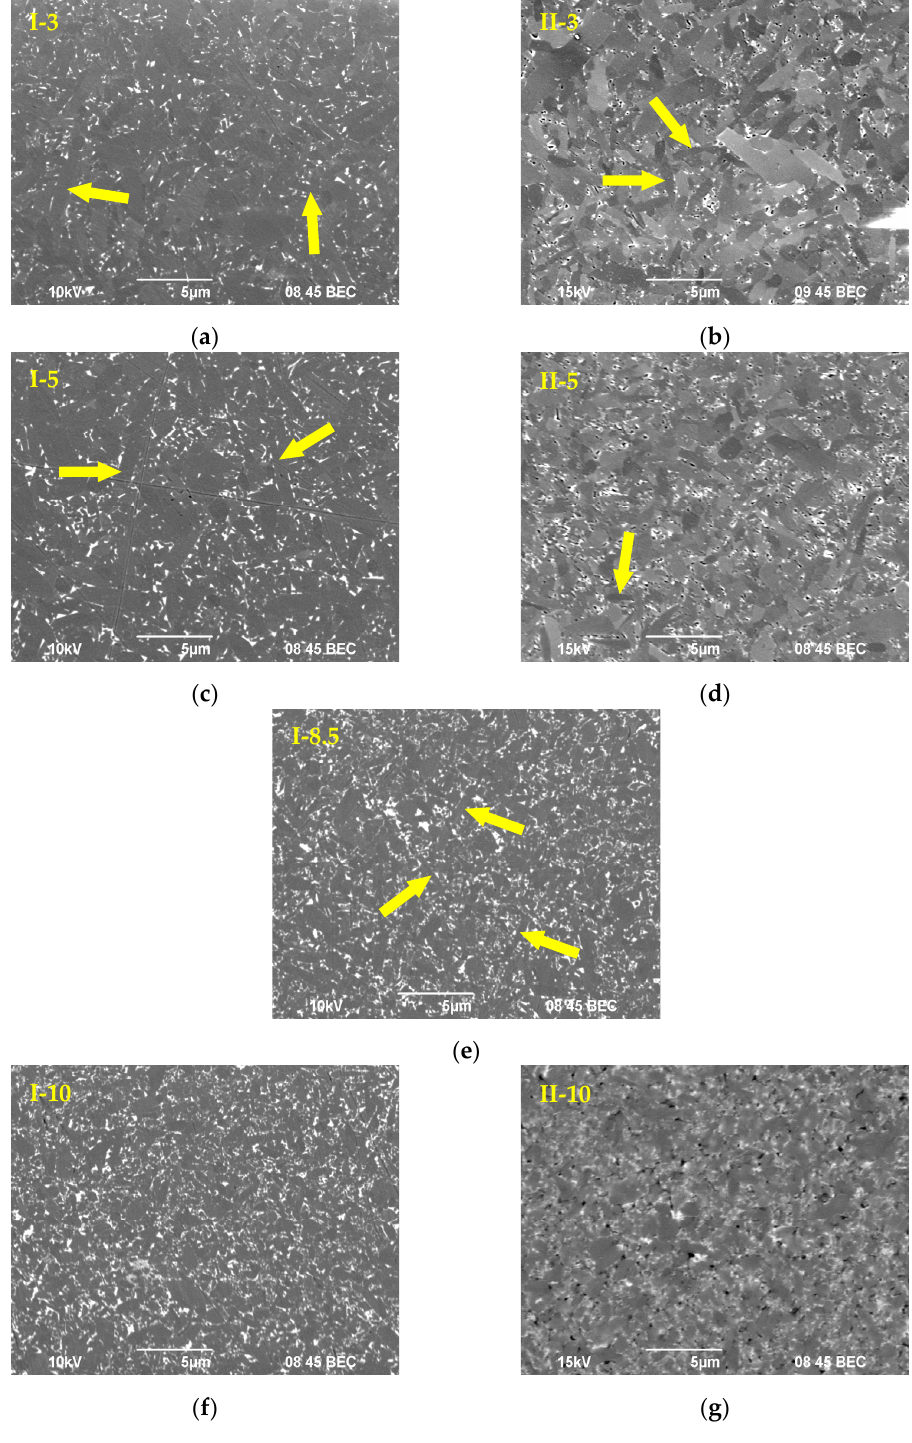
Figure 5. SEM images of the ceramic samples with different amounts of the sintering additive: ( a , b ) 3% wt.; ( c , d ) 5% wt.; ( e ) 8.5% wt.; ( f , g ) 10% wt. The arrows point to the elongated β‐ Si 3 N 4 grains